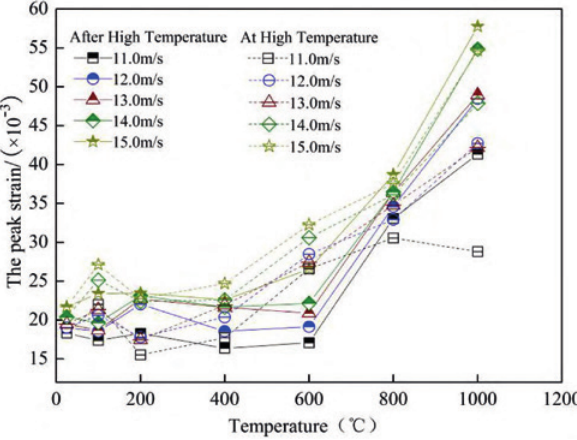
Fig. 8: The peak strain variations of sandstone after as well as under high temperatures